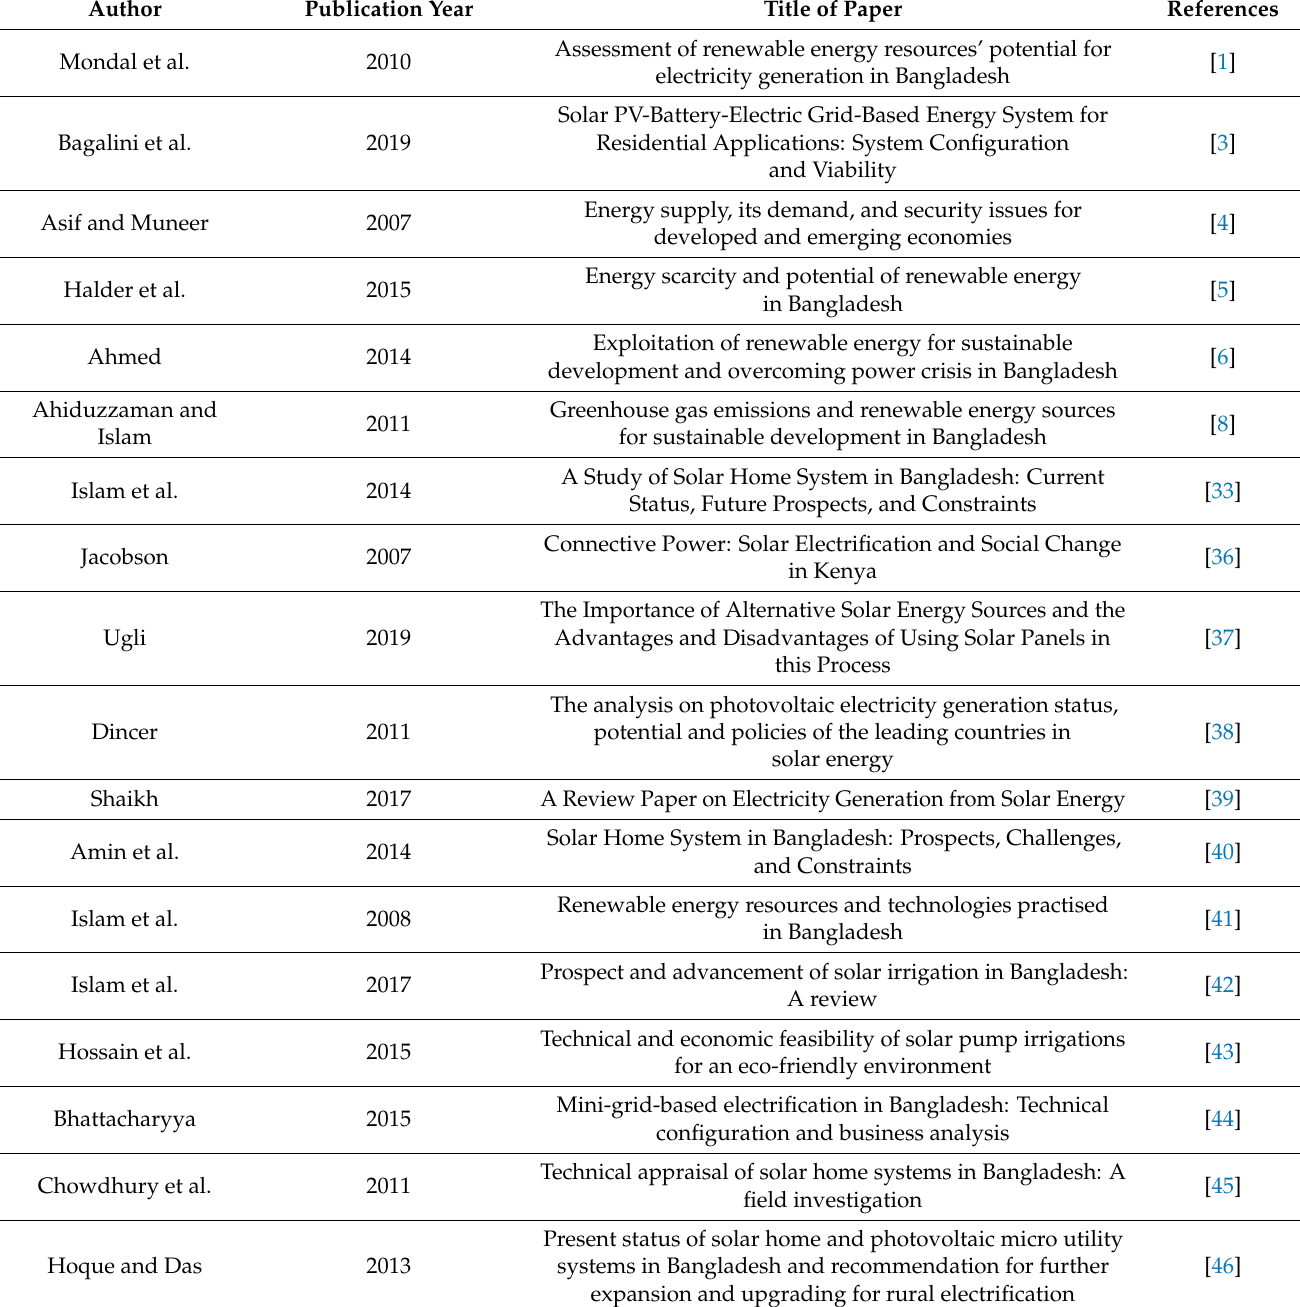
Table 1. Existing research works related to solar energy in